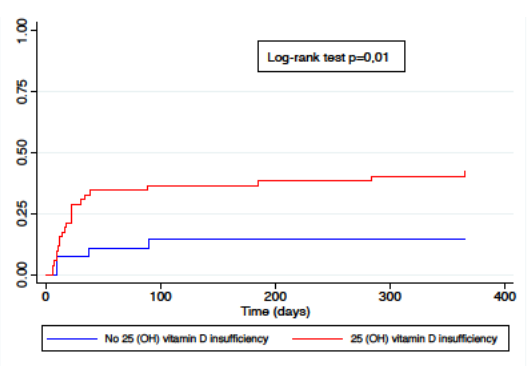
Figure 2. Cumulative incidence of TCMR by pre LT vitamin D status.